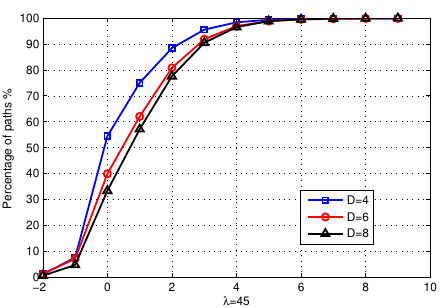
Figure 12. The cumulative distribution of the increased number of hops for the topologies with λ = 45.